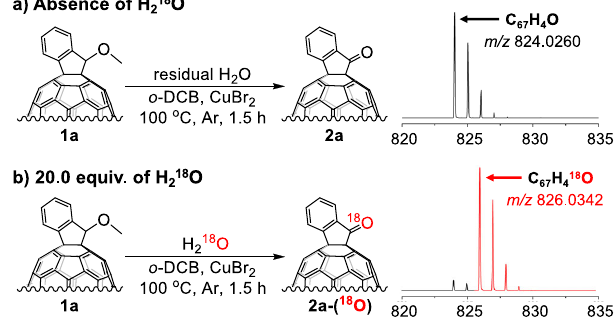
Fig. 2 18 O isotope-labelling experiments. Reaction conditions: 1a (3.0 mg, 3.6 μ mol), CuBr 2 (4.0 equiv.), o -DCB (3.0 mL) at 100 °C for 1.5 h in a sealed